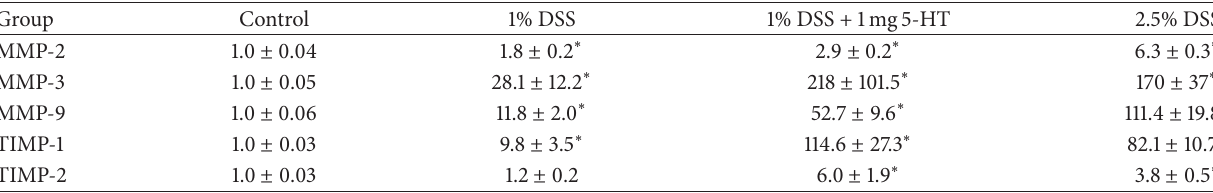
Table 4: Analysis of MMPs mRNA in mouse colon.